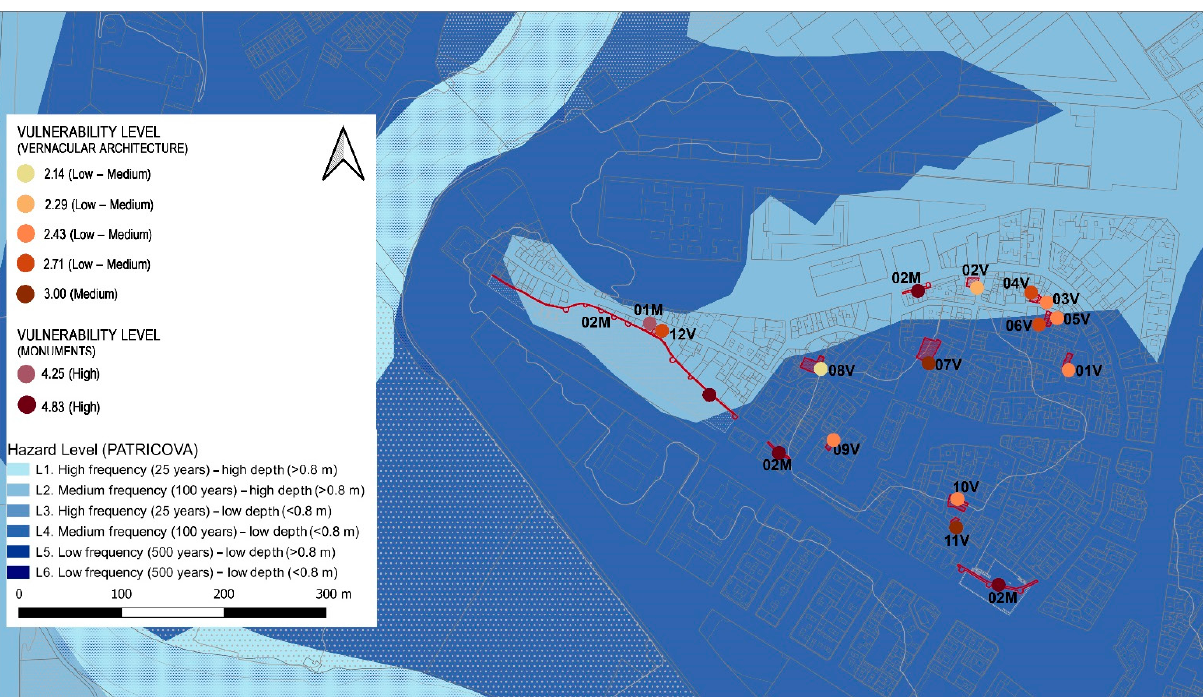
Figure 9. Result map. Figure 9. Result Table 9. Comparison of characteristics affecting the vulnerability of vernacular earthen architecture.